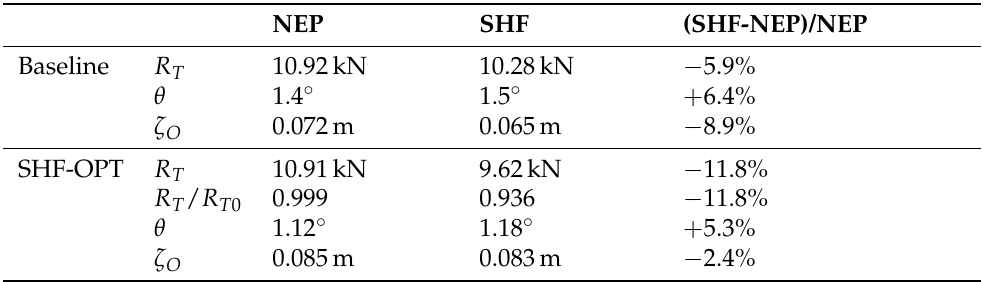
Table 6. Comparison of total resistance, trim angle and sinkage computed with SHIPFLOW (SHF) and Neptuno